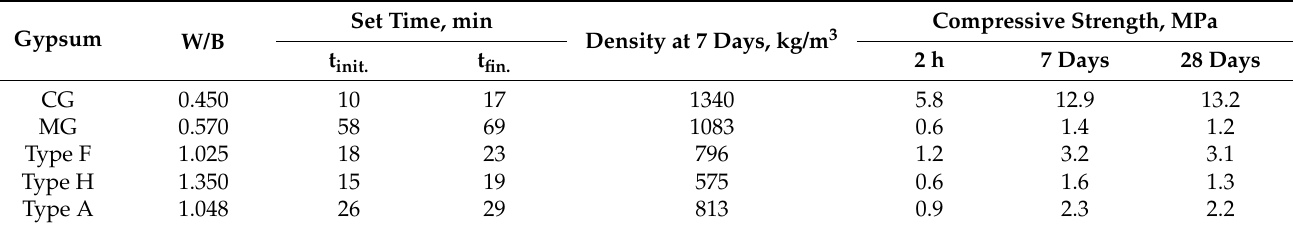
Table 5. Properties of commercial gypsum and CDW gypsum binder treated for 24 h at 130 ◦